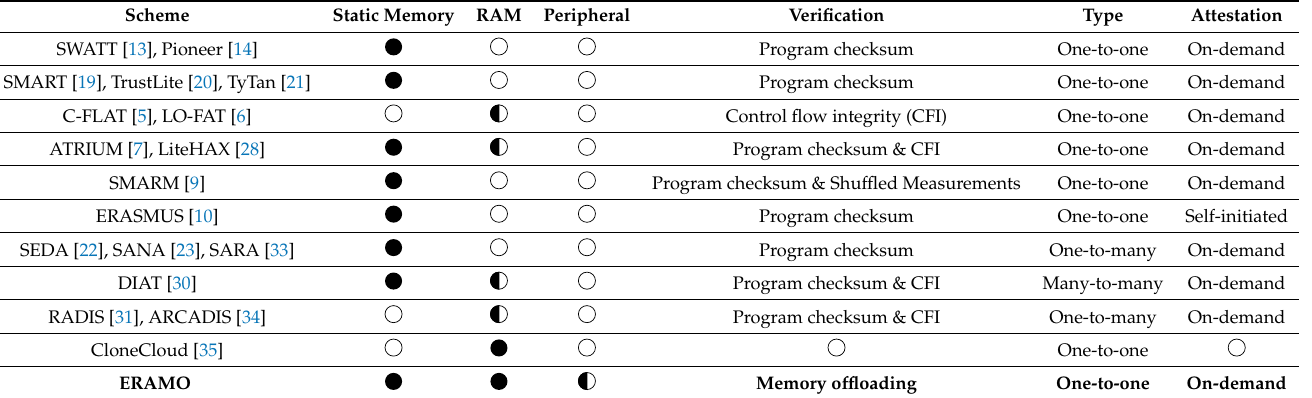
Table 1. Related work summary.